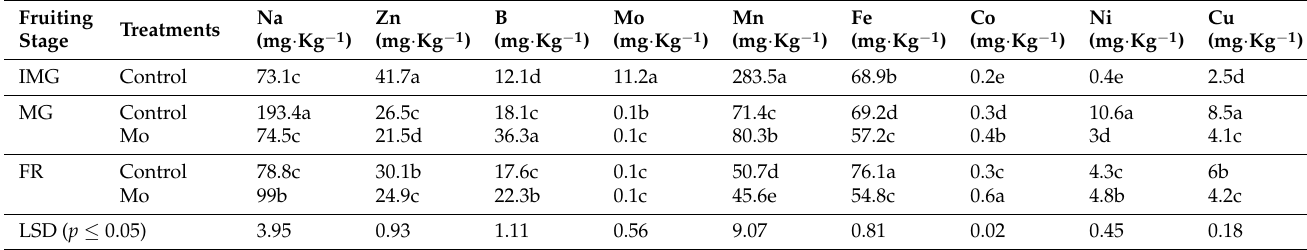
Table 9. Micronutrient concentrations in fruit pulp of loquat as affected by the foliar application of molybdenum. Fruiting Stage